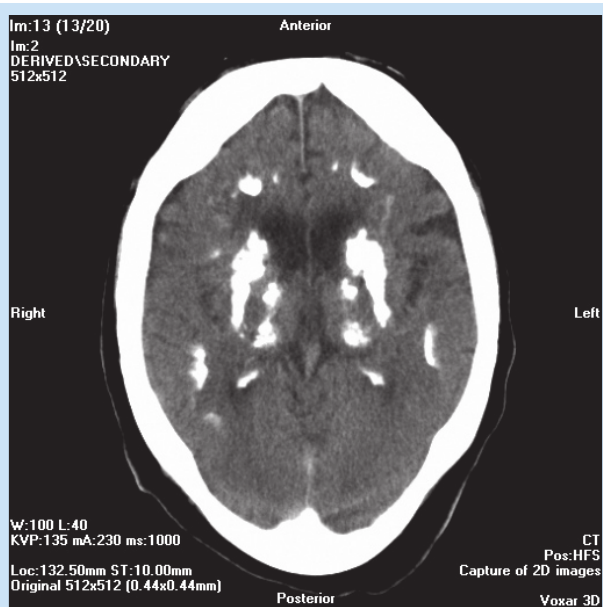
Fig. 2. Dense calcification of the basal ganglia, thalami, nuclei and subcortical white